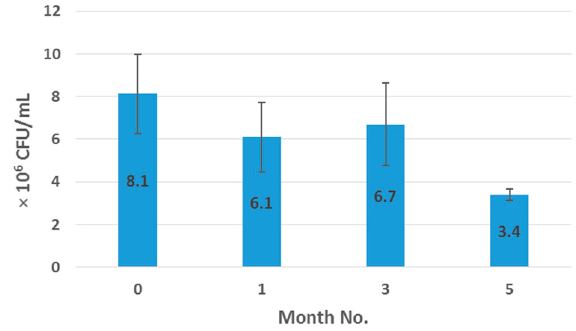
Figure 8. Growth of bifidobacteria from 50% sample formulation. Data points are averages from two independent fermentations.